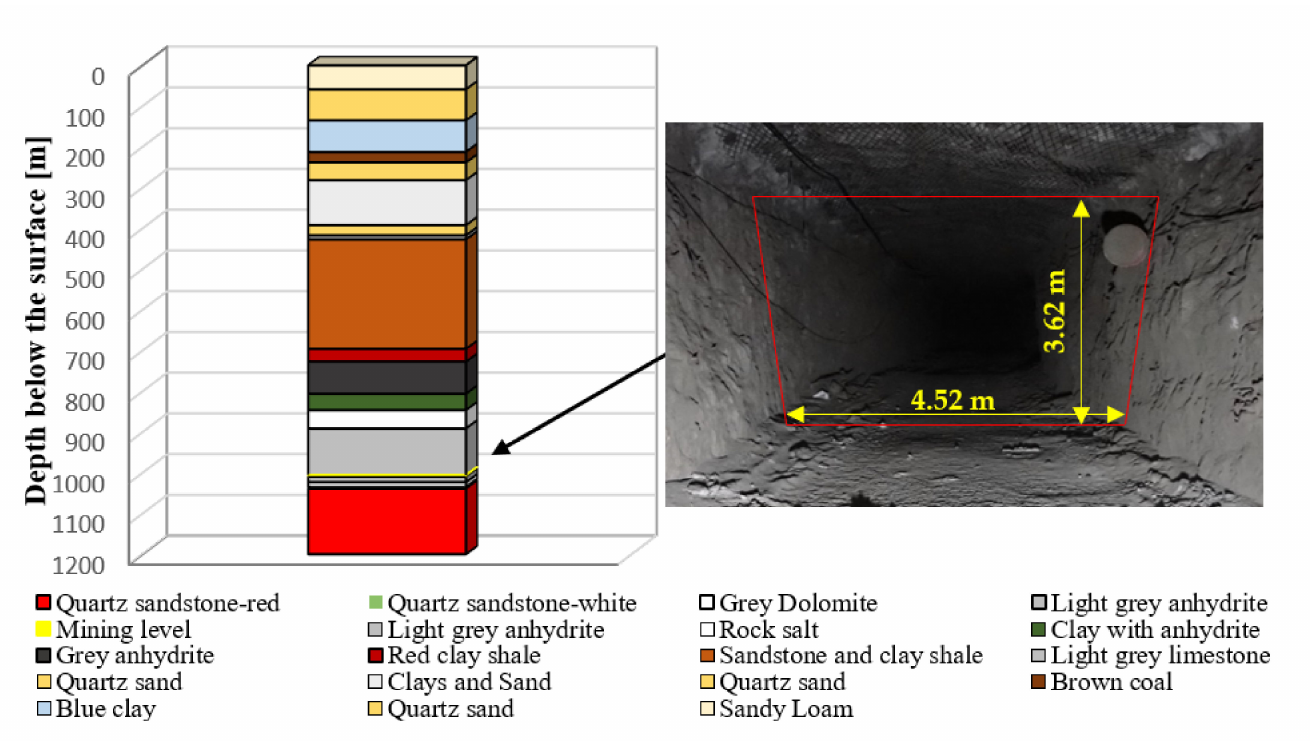
Figure 1. Geologic profile of analyzed mining